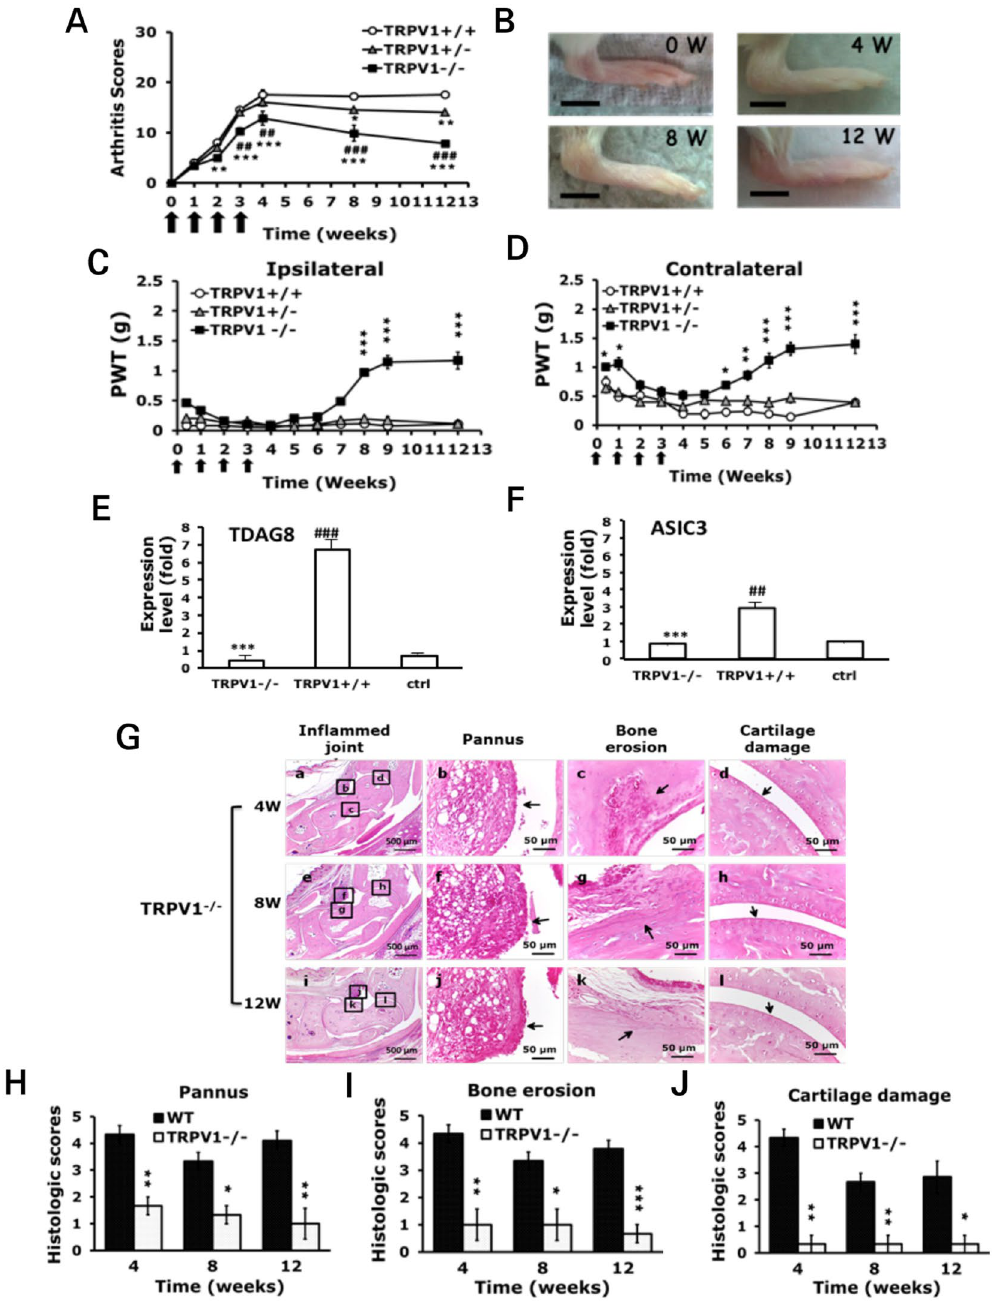
Figure 4. Arthritic TRPV1 − / − mice show reduced mechanical hyperalgesia in the late phase. ( A ) Arthritis scores in TRPV1 + / + , TRPV1 + / − and TRPV1 − / − mice. * p < 0.05, ## ** P < 0.01, ### *** p < 0.001: * TRPV1 − / − or TRPV1 + / − vs TRPV1 + / + , # TRPV1 + / − vs TRPV1 − / − by two-way ANOVA. ( B ) Joint swelling at 0, 4, 8, 12 weeks in TRPV1 − / − mice. ( C , D ) PWT measured at weekly intervals after the first CFA injection. Data are mean ± SEM of total tested mice (n = 7 for TRPV1 + / + , n = 6 for TRPV1 + / − and n = 7 for TRPV1 − / − group). * p < 0.05, ** P < 0.01, *** p < 0.001: TRPV1 − / − vs TRPV1 + / + by two-way ANOVA. ( E , F ) qRT-PCR analysis of TDAG8 or ASIC3 gene expression in ipsilateral DRG at 12 weeks of TRPV1 + / + or TRPV1 − / − mice, or at 0 weeks of TRPV1 + / + mice (ctrl). *** p < 0.001, TRPV1 -/- vs TRPV1 + / + ; ### p < 0.001, TRPV1 + / + vs ctrl by one-way ANOVA. ( G ) Samples of ipsilateral joints at 4, 8, 12 weeks stained with hematoxylin and eosin are shown in (a- l). Data are mean ± SEM severity score for synovial inflammation ( H ), bone erosion ( I ), and cartilage damage ( J ). * p < 0.05, ** P < 0.01, comparing TRPV1 − / − vs WT by nonparametric Mann-Whitney U